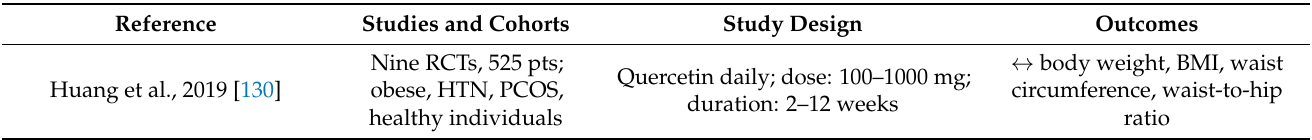
Table 2. Published meta-analyses of randomized clinical trials investigating the impact of quercetin on classical cardiovascular risk